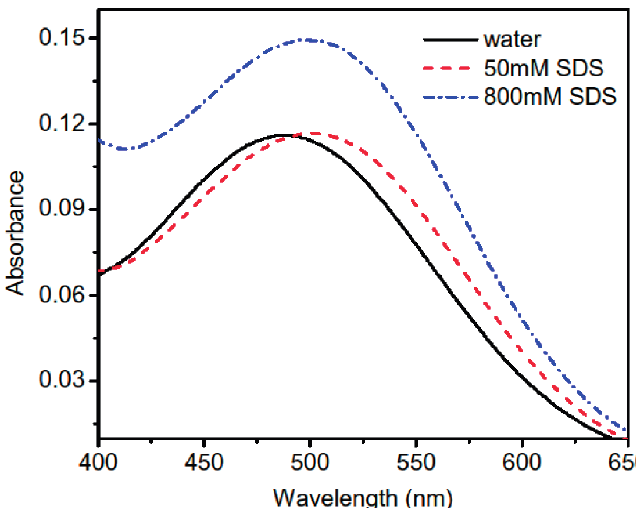
Figure 2. Absorption Spectra of Dye in Water and in Different Concentration of Sodium Dodecyl Sulfate (SDS).